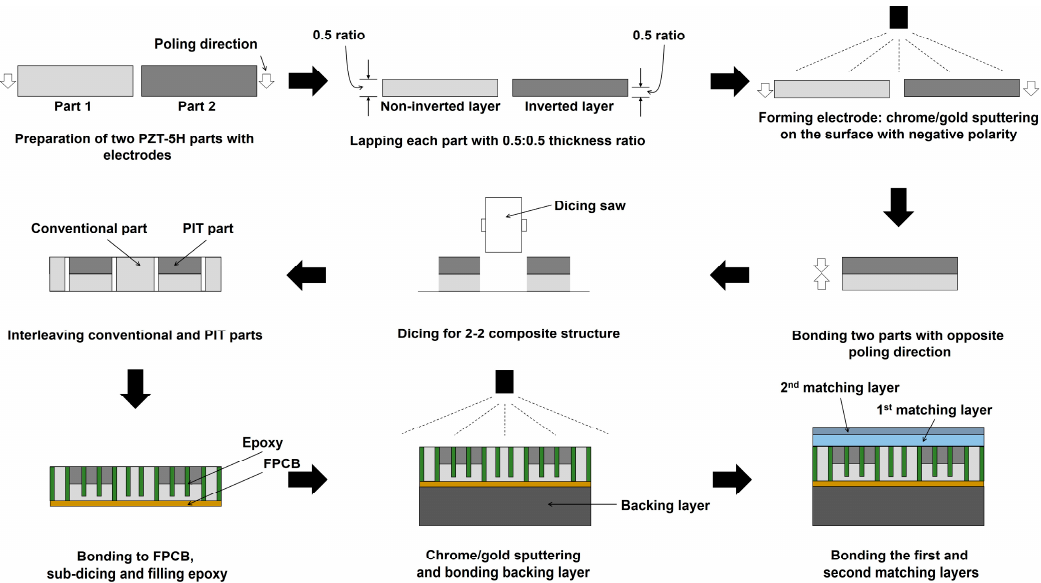
Figure 5. Fabrication process of the proposed prototype array transducer. The improved interleaved technique was employed for this fabrication. Sensors 20 20 , 14 , x